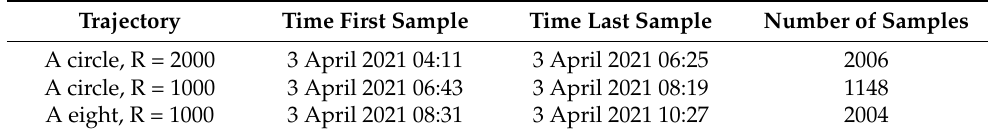
( b ) Figure 8. The incident histogram of the three trajectories ( a ). Sound velocity profiles of the water column during the GNSS/Acoustic survey ( b ). To estimate the absolute horizontal position of a seafloor transponder, we used the circle line observation. As shown in Figure 9a, the round trip travel times of big circle and small circle track are approximately 3.4 and 2.7 s, respectively. Using the ray-tracing calculations and Equation (7), the travel time delay and horizontal normalized travel time delay can be estimated, as shown in Figure 9b. The root mean square (RMS) values of the travel time delay and horizontal normalized travel time delay are 0.18 and 0.11 ms, respectively.